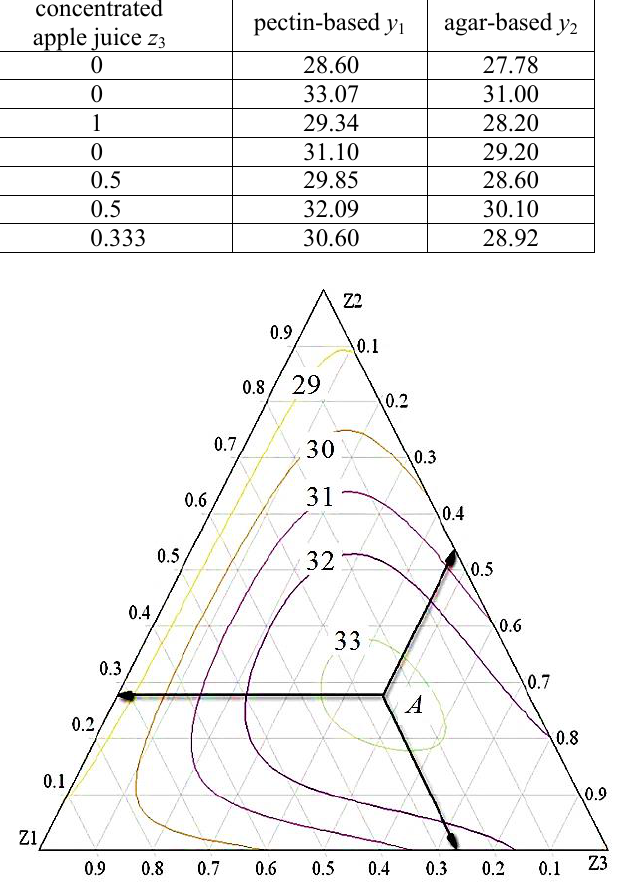
Fig. 7. Isolines of the plastic strength of the jelly mass based on pectin.